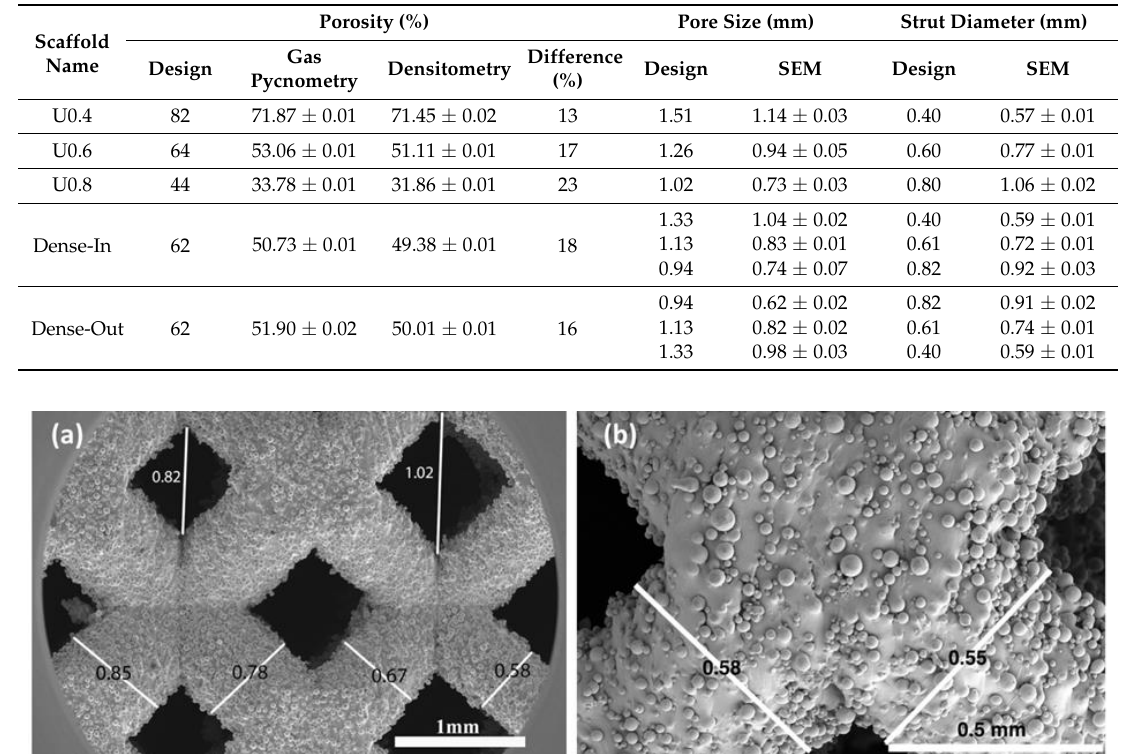
Table 1. The morphometric parameters of uniform and gradient BCC structures based on CAD designs, gas pycnometry, digital densitometry and SEM.